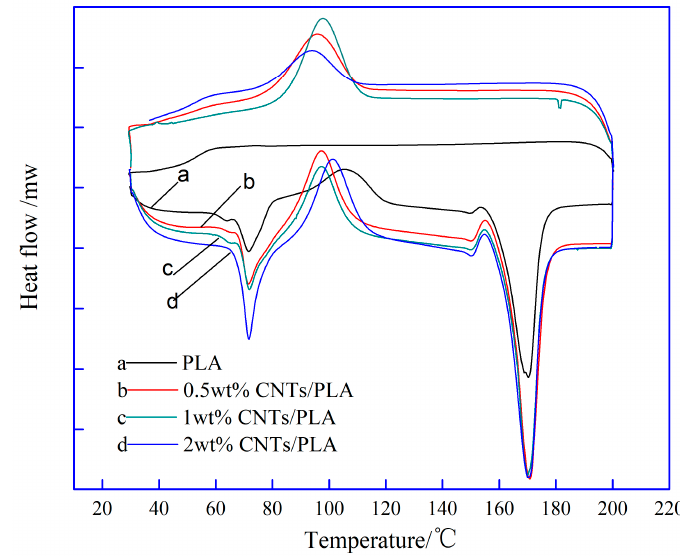
Figure 3. DSC curves of PLA sutures with different contents of CNTs.